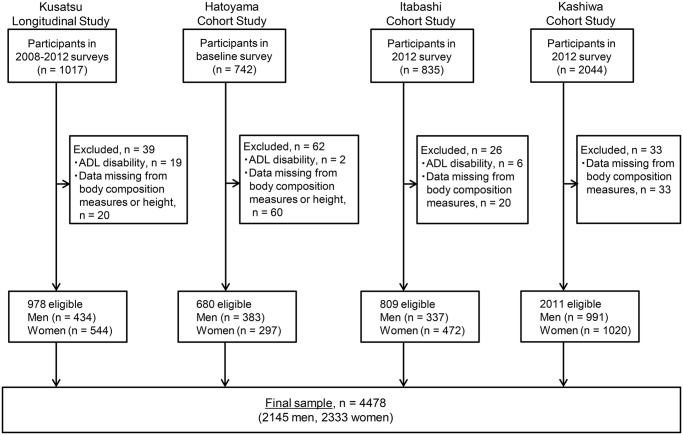
Schematic of participant selection processes in each included cohort study.ADL = activities of daily living.